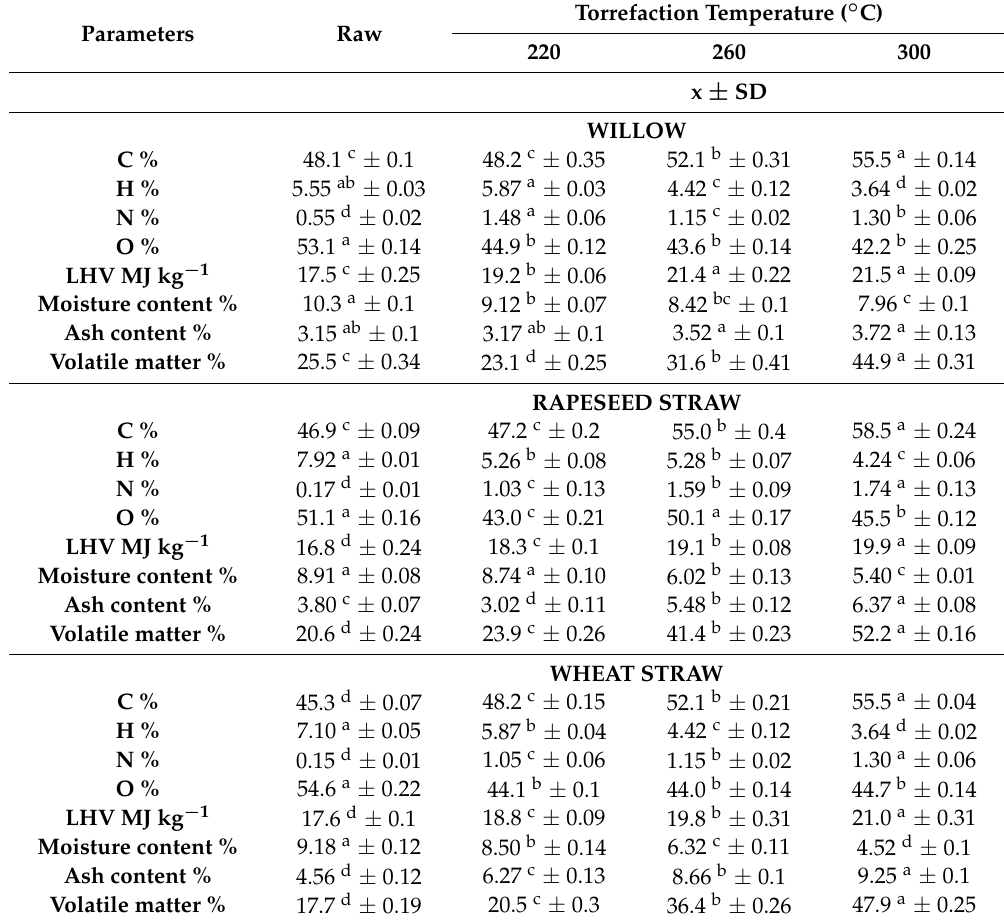
Table 3. Summary of examined parameters for biomass, raw, and torrefied for 60